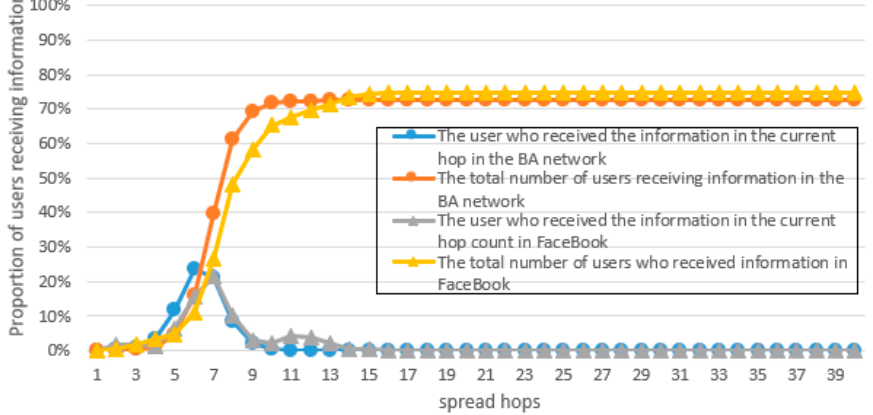
Figure 10. The dissemination process of the privacy information of high popularity users in the BA and the Facebook networks.